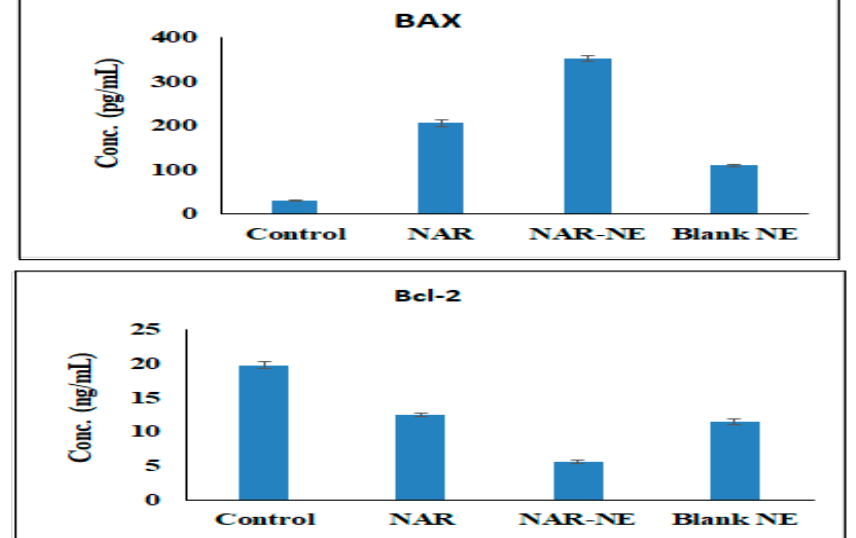
Figure 14. Effect of the IC 50 concentrations of free NAR, blank NE, and NAR-NE on the expression of Bcl-2 and Bax protein in A549 cancer cells ( p < 0.05 for free NAR vs. NAR-NE).